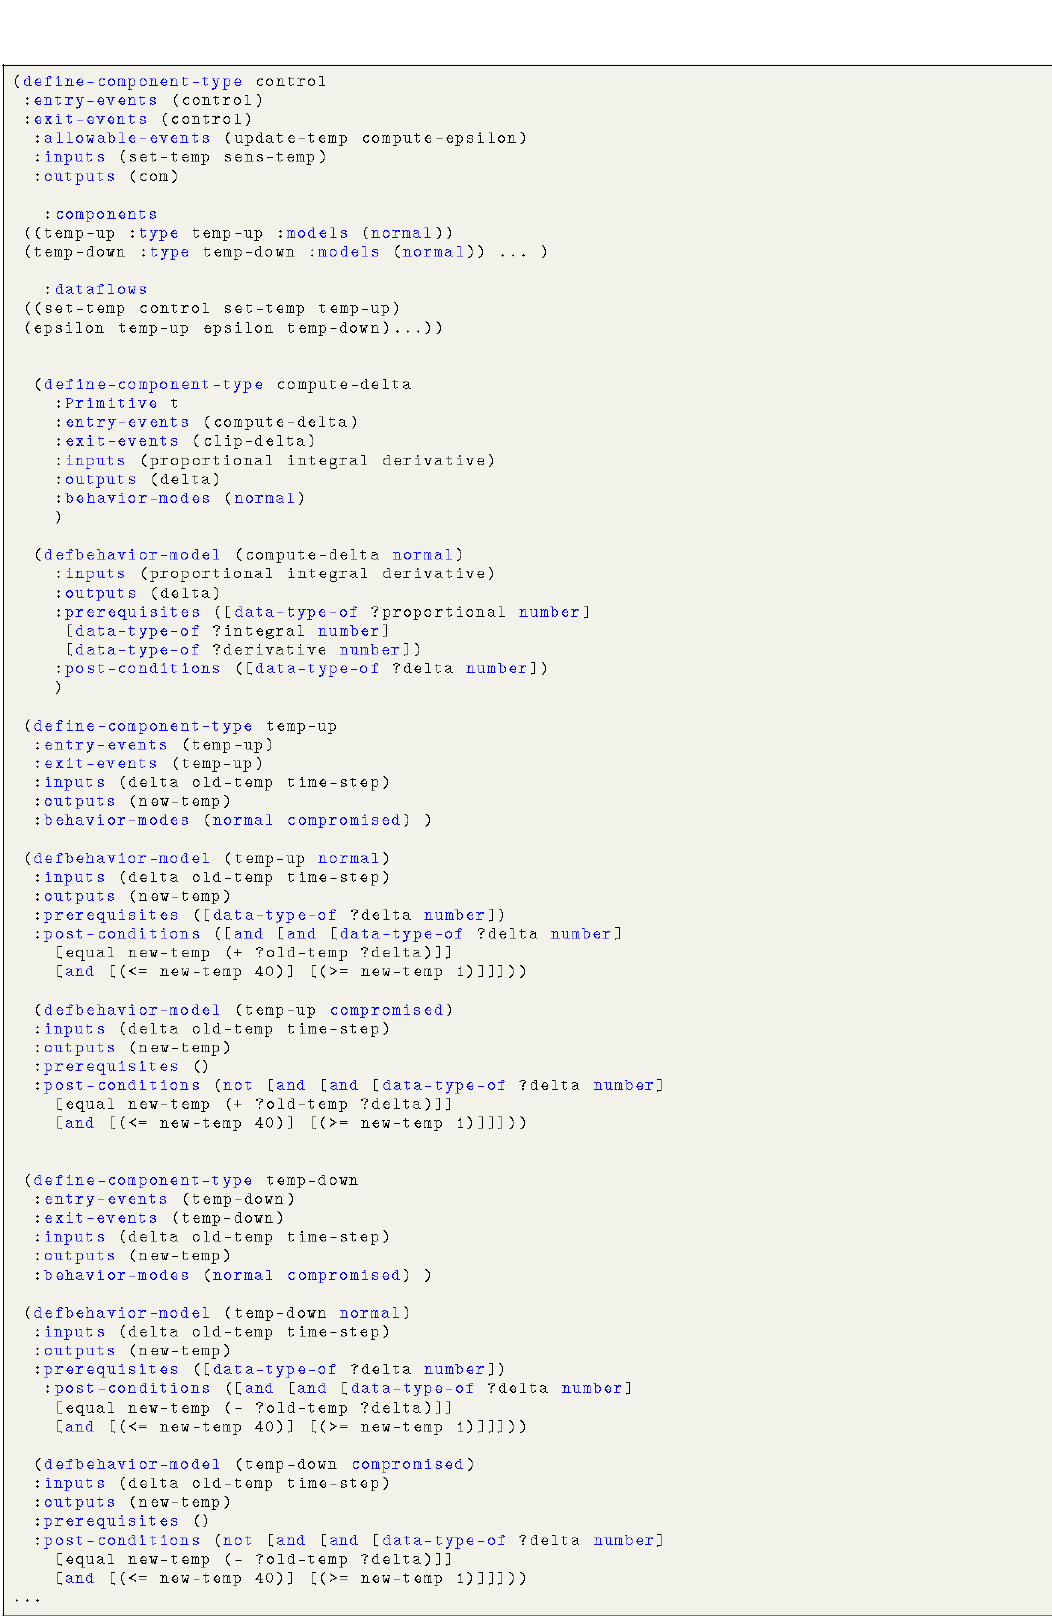
Figure 2. An example specification (AppSpec) of a temperature